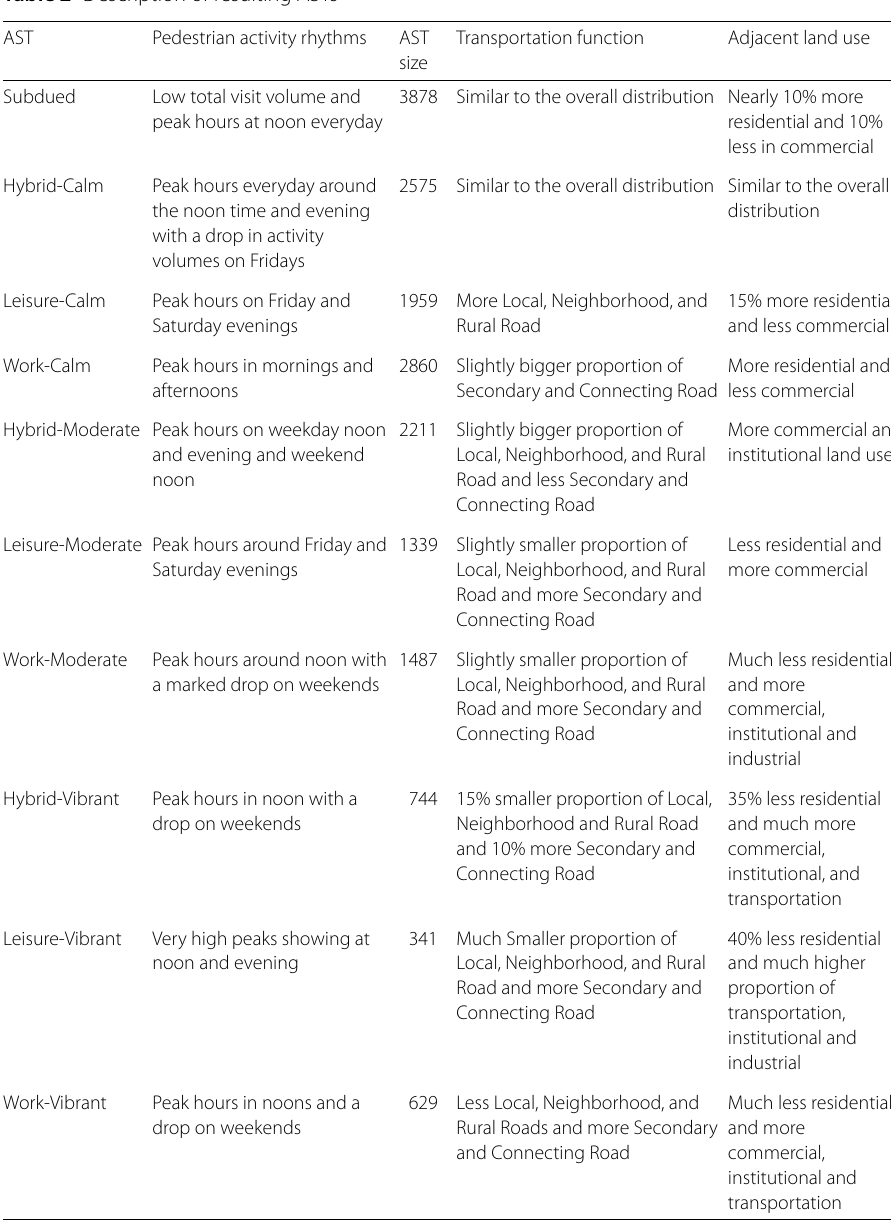
Table 2 Description of resulting